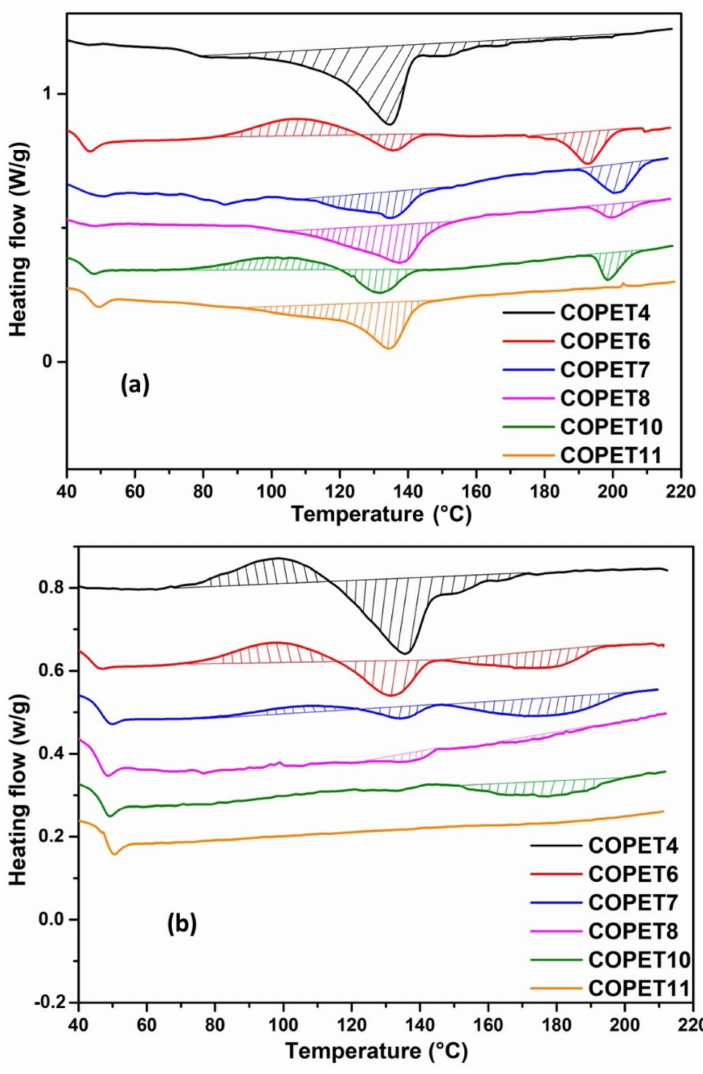
Figure 6. Influence of SSP temperature on thermal properties measured by DSC: ( a ) first heating and ( b ) second